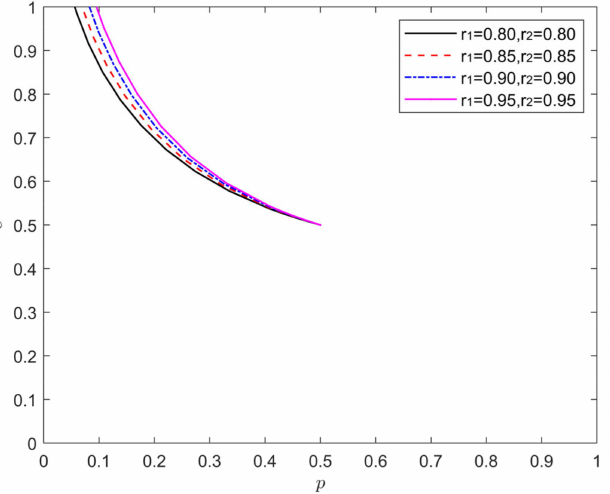
Figure 2. The development of the game’s strategy in a (optimistic, optimistic)